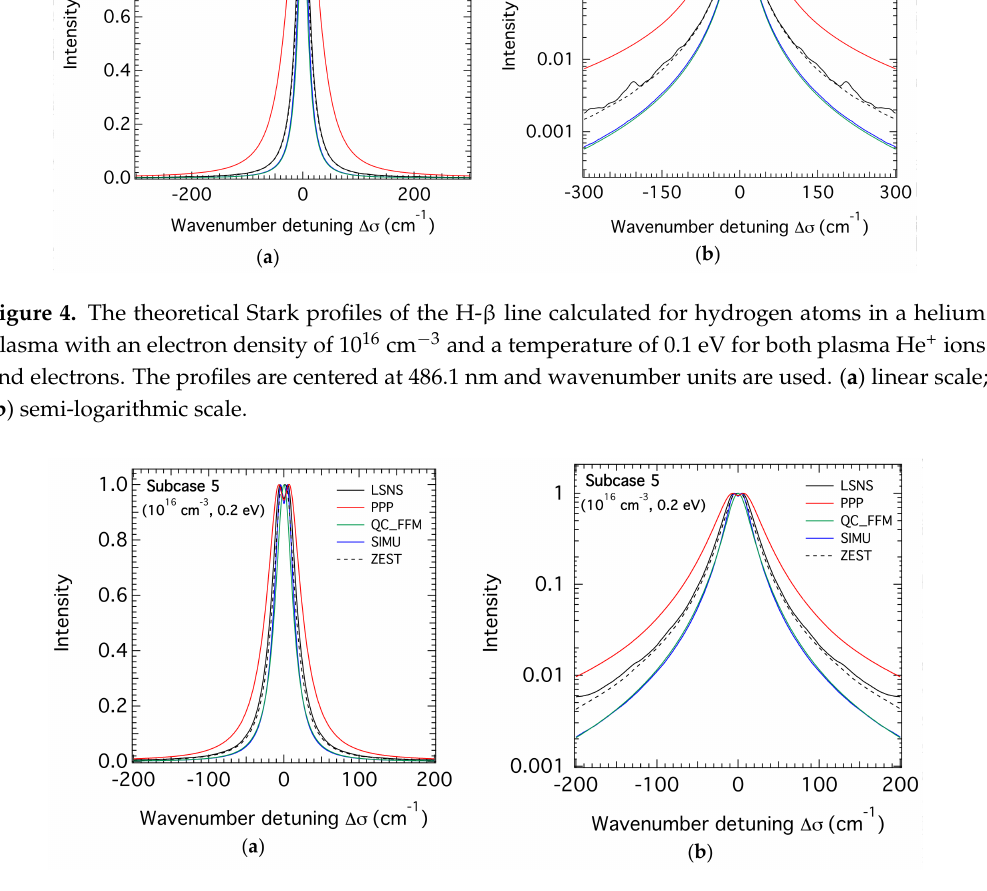
Figure 5. The same as Figure 4 but T e = T i = 0.2 eV. The same line styles and code colors as Figure 4 are used. ( a ) linear scale; ( b ) semi-logarithmic scale.